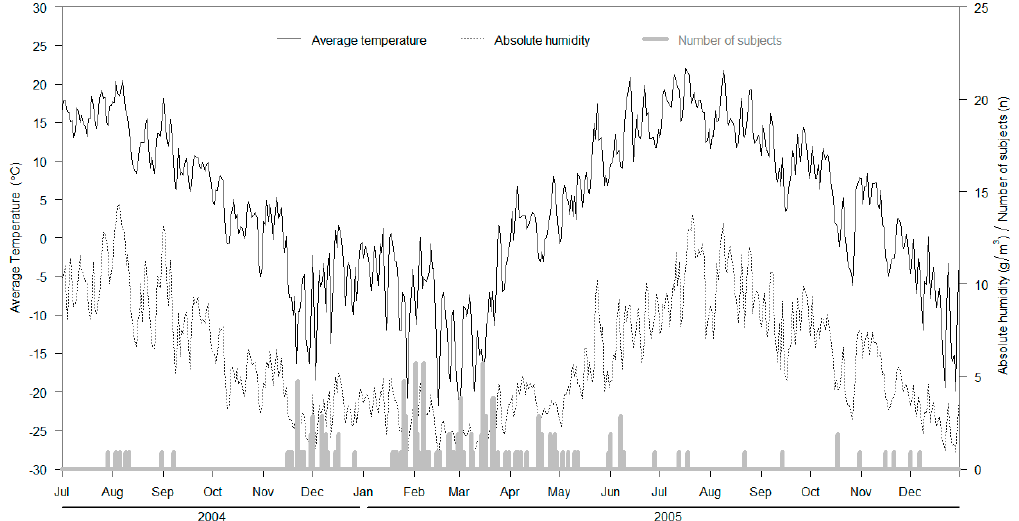
Figure 1. Incidence of rhinovirus infections, average temperature (°C; black solid line) and absolute humidity (AH) (g/m 3 ; grey dotted line) during the study period. The average and mean and maximal changes during the hazard and reference periods are presented in Table 1.